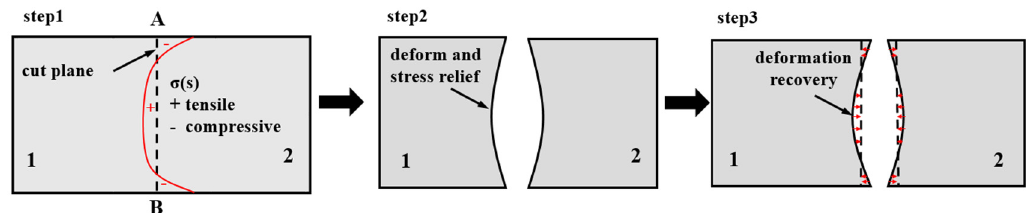
Figure 6. A schematic representation of the principle and steps of the contour method.